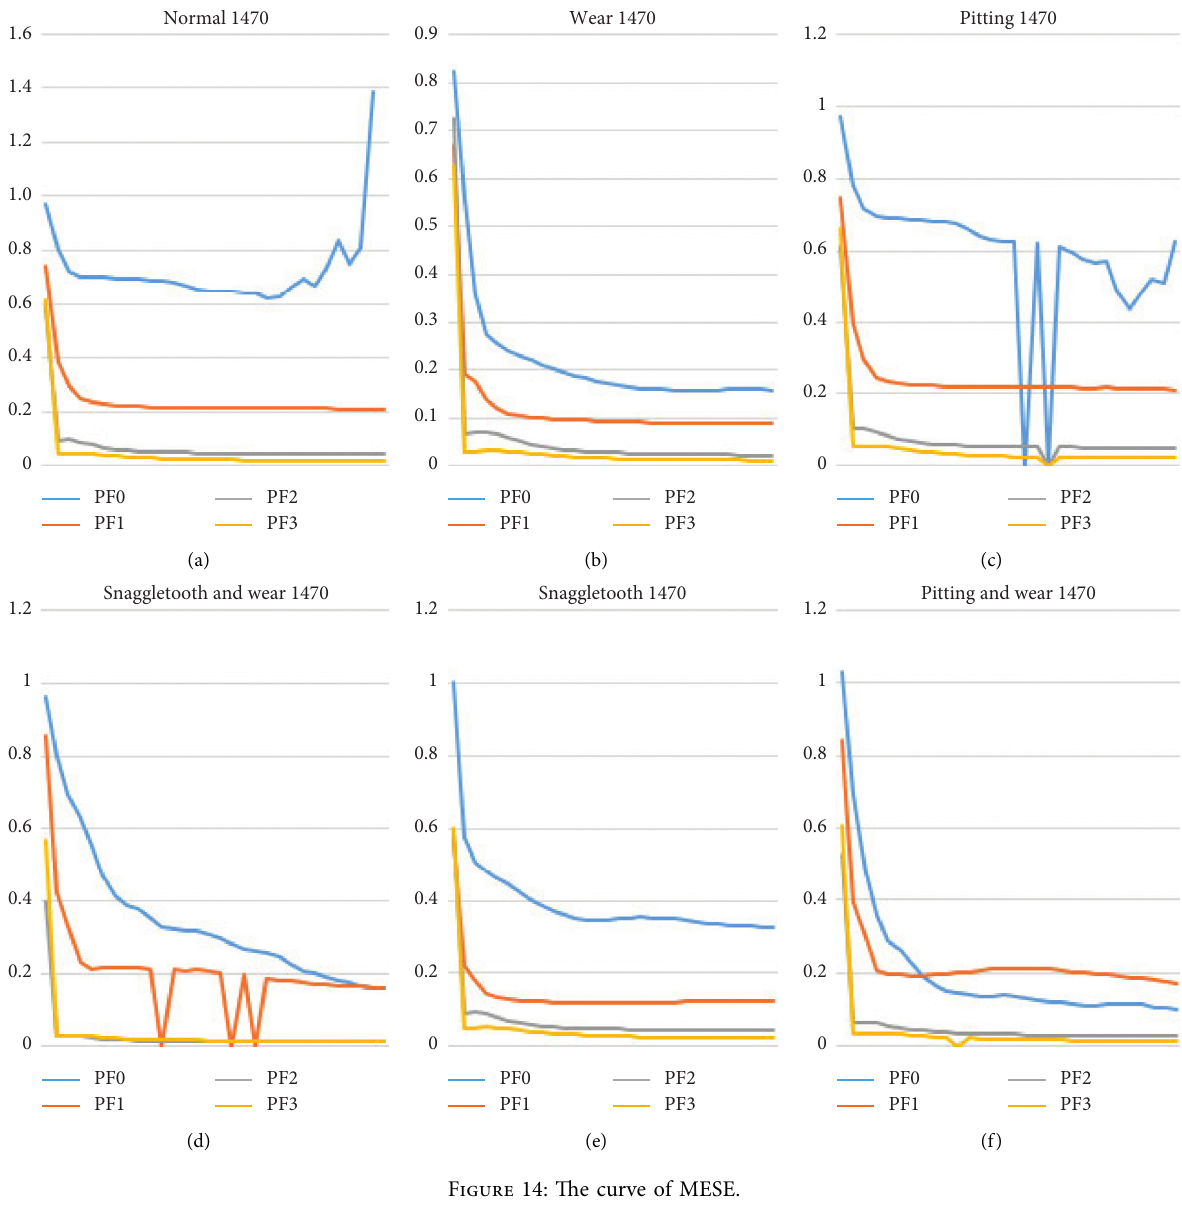
Figure 14: The curve of MESE.